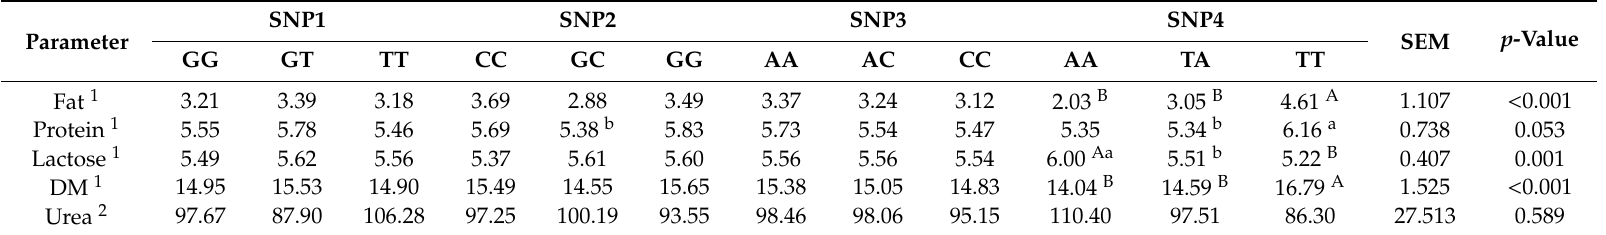
Table 3. Milk composition and urea level from Zošl’achten á valaška sheep in relation to particular genotypes of SLC27A3 gene polymorphisms. Parameter